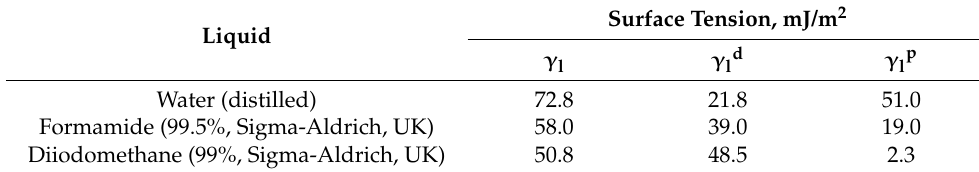
Table 2. Characteristics of standard liquids.